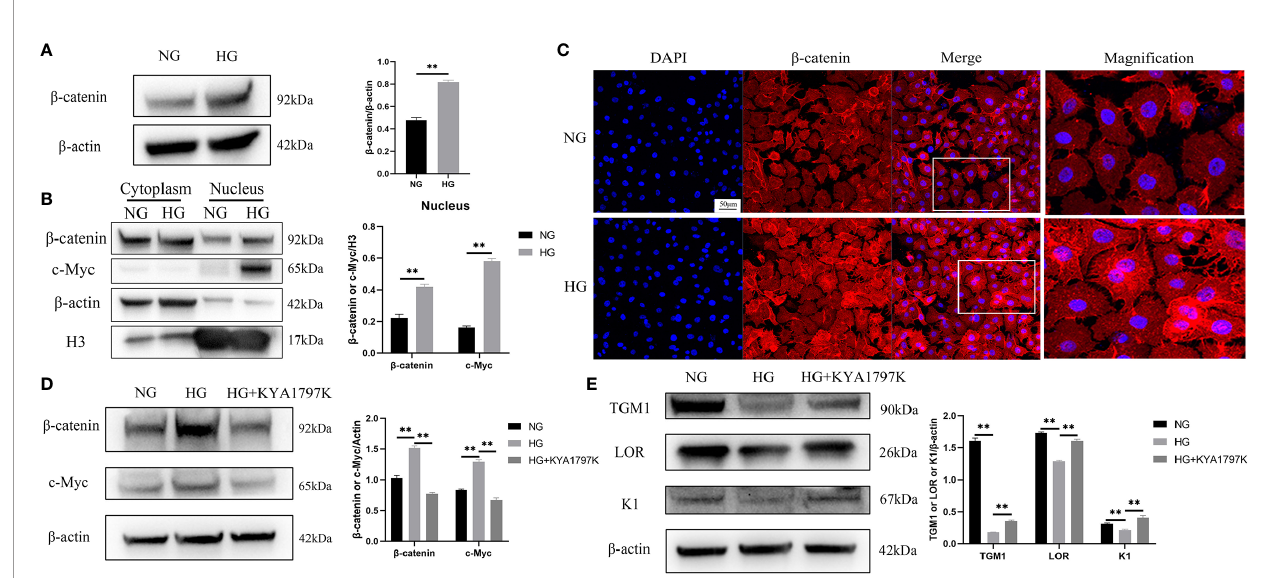
FIGURE 3 | High glucose causes increased c-Myc by activating the WNT/ b -catenin pathway (A) Total b -catenin expression was analyzed by western blot. (B) The expressions of b -catenin and c-Myc in the cytoplasm and nucleus were analyzed by western blot. (C) The expression of b -catenin was determined by immuno fl uorescence assay. The nuclei were stained blue using DAPI. Magni fi cation: ×200, Scale bar = 50 m m. (D, E) HaCaT cells were pre-treated with Wnt/ b - catenin inhibitor (KYA1797K, 25 m M) for 24 h, and then expressions of b -catenin, c-Myc (D) , TGM1, LOR, and K1 (E) were analyzed by western blot. Data were shown as the mean ± SEM measured in triplicate from three independent experiments. ANOVA followed by Tukey ’ s multiple comparisons test were performed to analyze the differences. ** P <